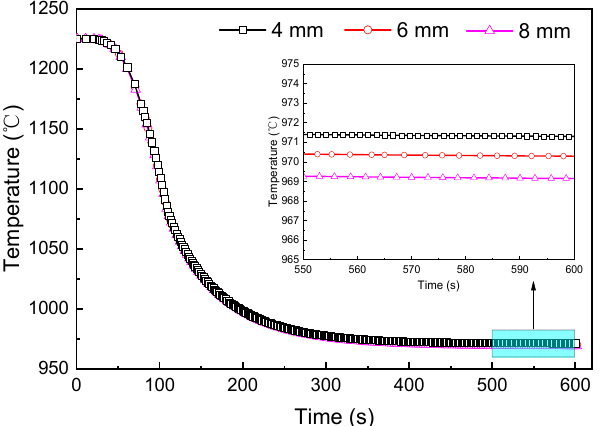
Figure 5. Temperature change at point C with time under different mesh sizes.